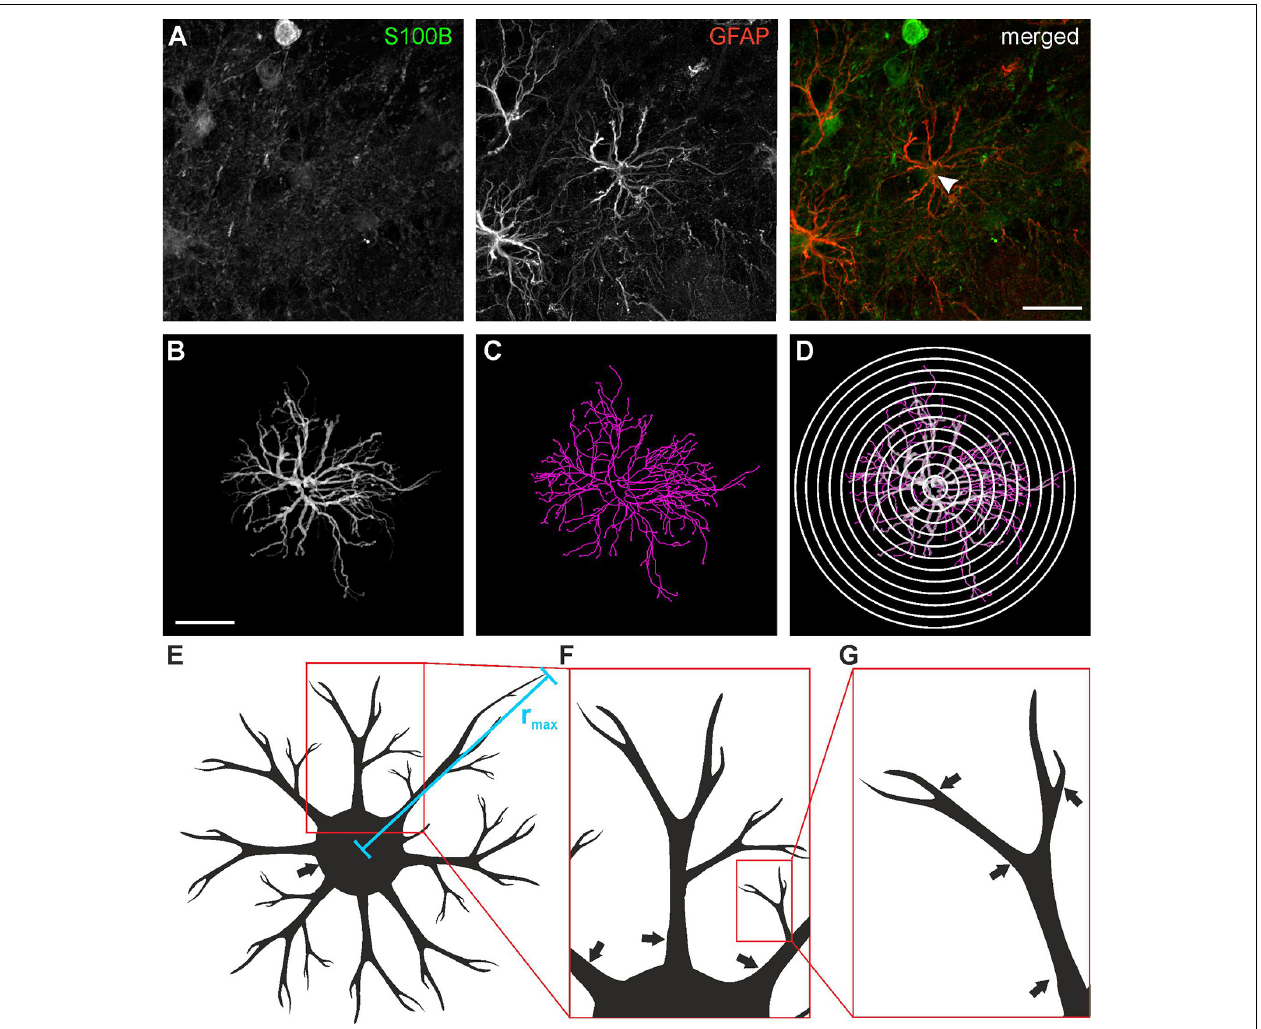
FIGURE 2 | Astrocyte tracing and Sholl analysis. (A) Anti-GFAP (red) and anti-S100B staining (green) of a type I astrocyte (arrowhead). (B) Three-dimensional tracing of the astrocyte depicted in panel (A) . (C) Filament plot of the traced astrocyte. (D) Sholl plot with 4 µ m interval. (E) Schematic drawing of astrocyte morphology analysis for the maximum radius ( r max ), (F) central processes (arrows) and (G) branch points (arrows). Scale bars: 20 µ